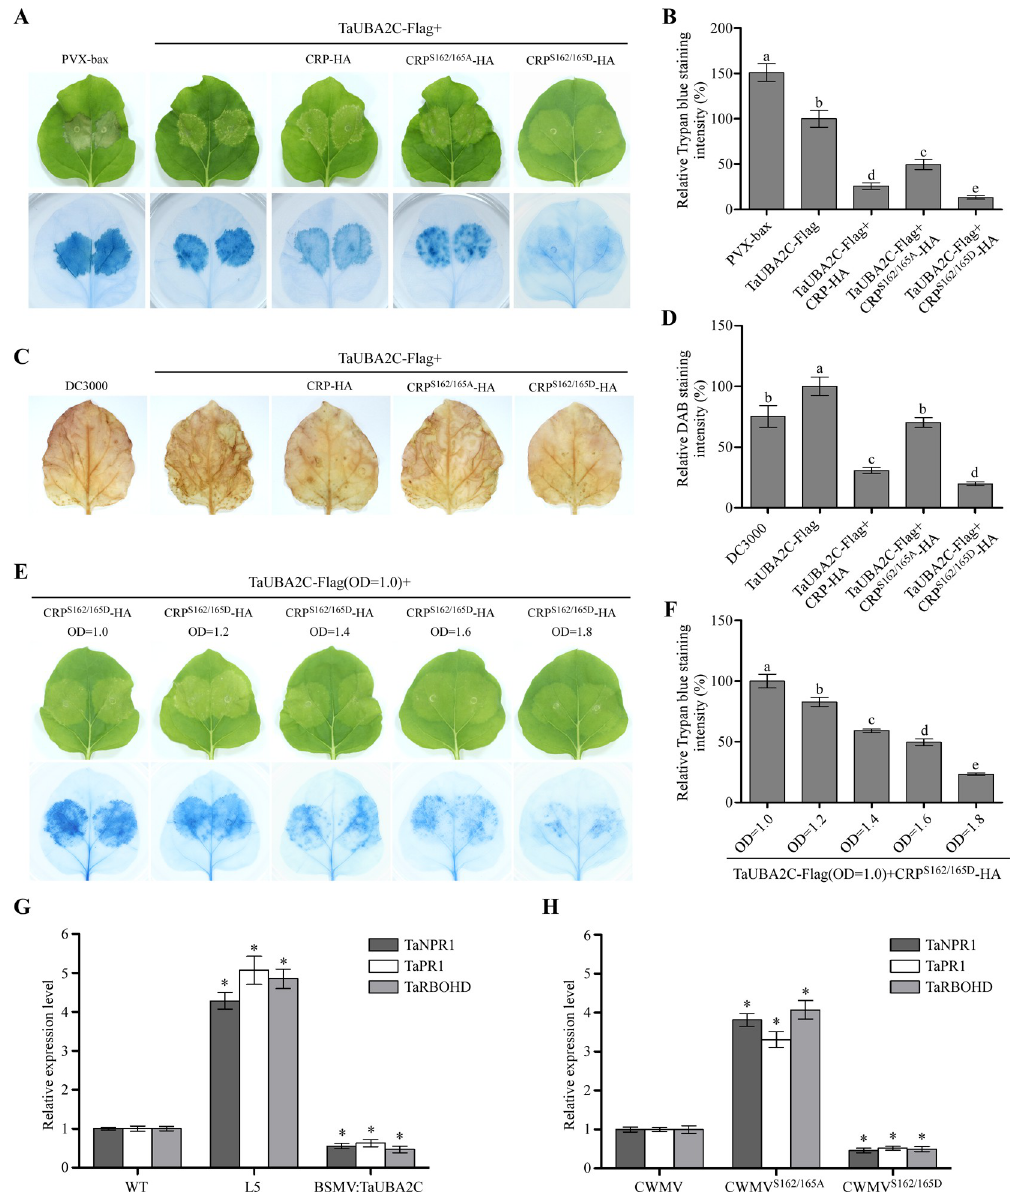
Fig 7. Phosphorylation of CRP at S162 and S165 suppresses cell death induced by TaUBA2C. A. Cell death in N . benthamiana leaf tissues expressing TaUBA2C, TaUBA2C+CRP, TaUBA2C+CRP S162/165A or TaUBA2C+CRP S162/165D . The infiltrated leaves were harvested and photographed at 5 days post agroinfiltration (upper panel), and then stained with a Trypan blue solution (lower panel). An N . benthamiana leaf inoculated with PVX-bax was used as a positive control. B. Measurement of the relative Trypan blue staining intensity shown in Fig 7A. Each treatment had three biological replicates, the data presented are the means ± SD. Different letters show statistically significant differences (P < 0.05, Tukey’s test). C. Assayed N . benthamiana leaves were stained with a DAB solution at 5 dpi. The N . benthamiana leaf inoculated with the wild type Agrobacterium DC3000 was used as a control. D. Measurement of the relative DAB staining intensity shown in Fig 7C. Each treatment had three biological replicates, the data presented are the means ± SD. Different letters show statistically significant differences (P < 0.05, Tukey’s test). E. N . benthamiana leaves co-inoculated with TaUBA2C and different concentrations of CRP S162/165D were harvested and photographed at 5 dpi (upper panel), and then stained with a Trypan blue solution (lower panel). F. Measurement of the relative Trypan blue staining intensity shown in Fig 7E. Each treatment had three biological replicates, the data presented are the means ± SD. Different letters show statistically significant differences (P < 0.05, Tukey’s test). G. Quantitative RT-PCR analyses of TaNPR1 , TaPR1 and TaRBOHD expressions in the wild type (WT), L5 transgenic and BSMV:TaUBA2C-inoculated plants. The data presented are the means ± SD, determined using the Student’s t -test. Each treatment had three biological replicates. � , P < 0.05. H. Quantitative RT-PCR analyses of TaNPR1